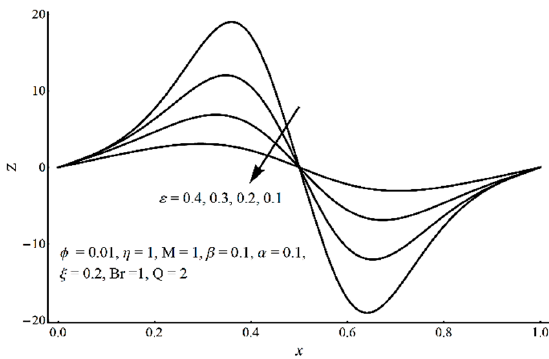
Figure 26. Heat transfer coefficient at the ciliated channel wall for different values of ε .